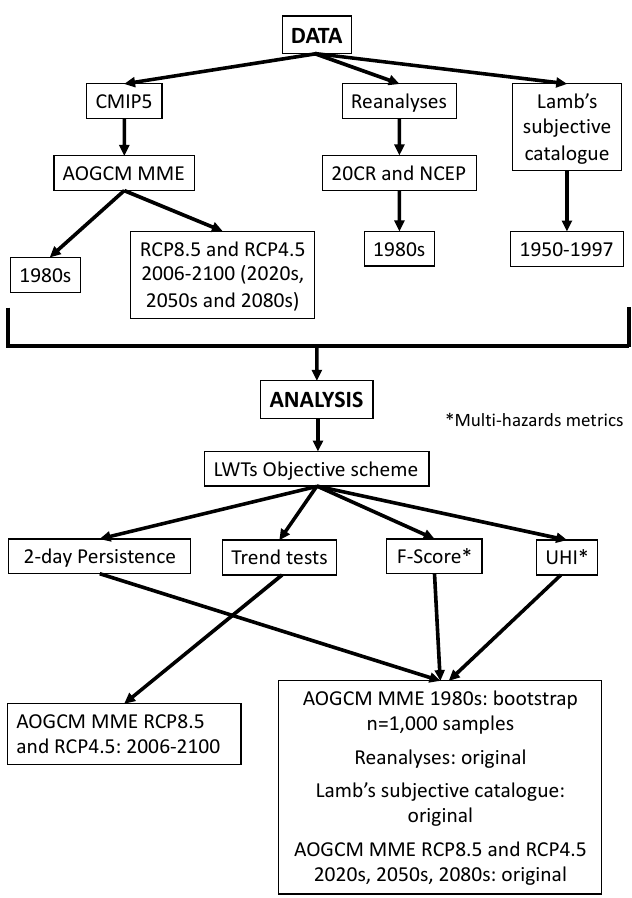
Figure 2. Main data and methodology steps. The figure synthesise the procedures described in Section 2. Methods and Data.